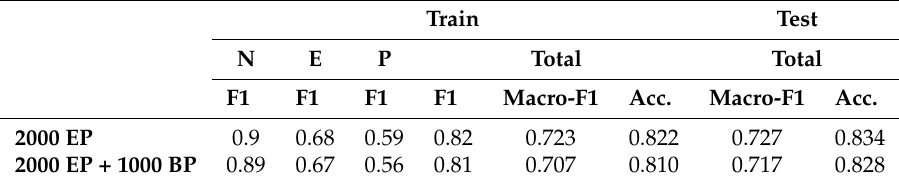
Table 6. Adding BP annotations to different partitions of the EP training set.